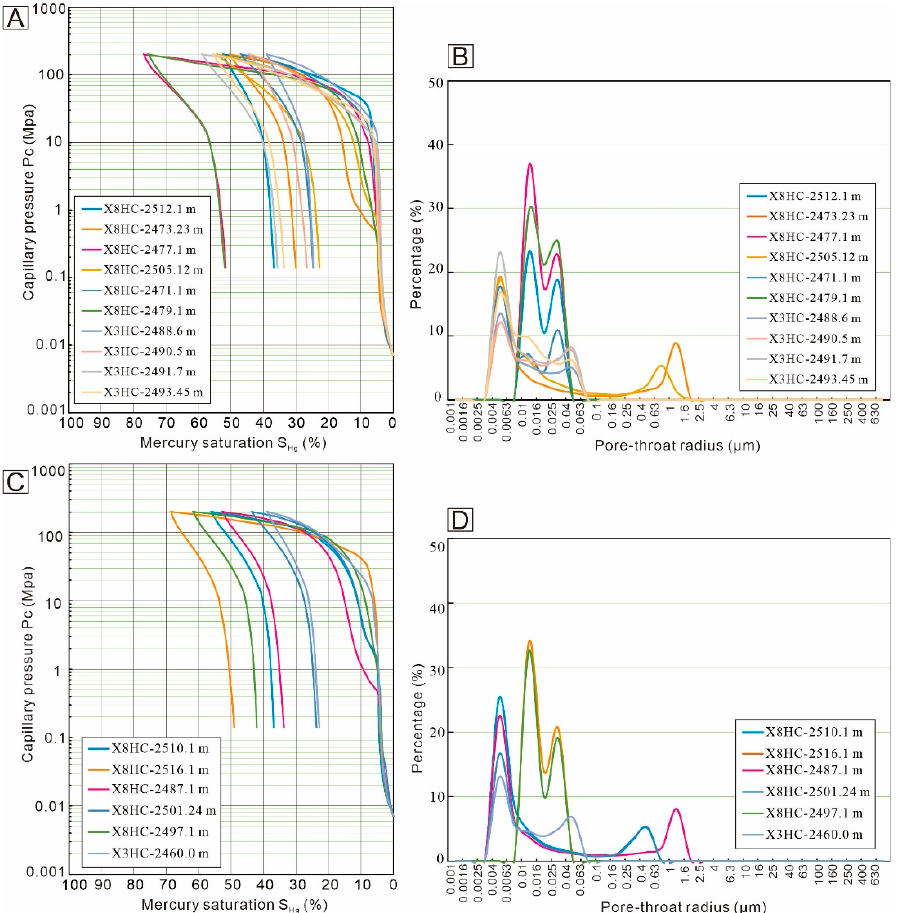
Figure 16. Mercury intrusion and extrusion curves and pore size distribution of SM ( A , B ) and SFMR ( C , D ). Table 3. Pore-throat parameters of different lithofacies of FGSRs from mercury intrusion